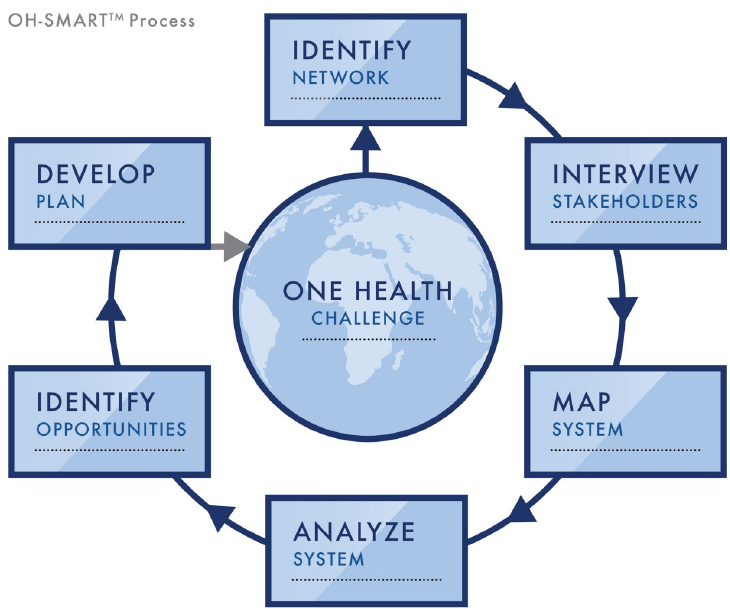
Fig 1. OH-SMART steps. Overview of the six OH-SMART steps used to evaluate One Health Challenges.